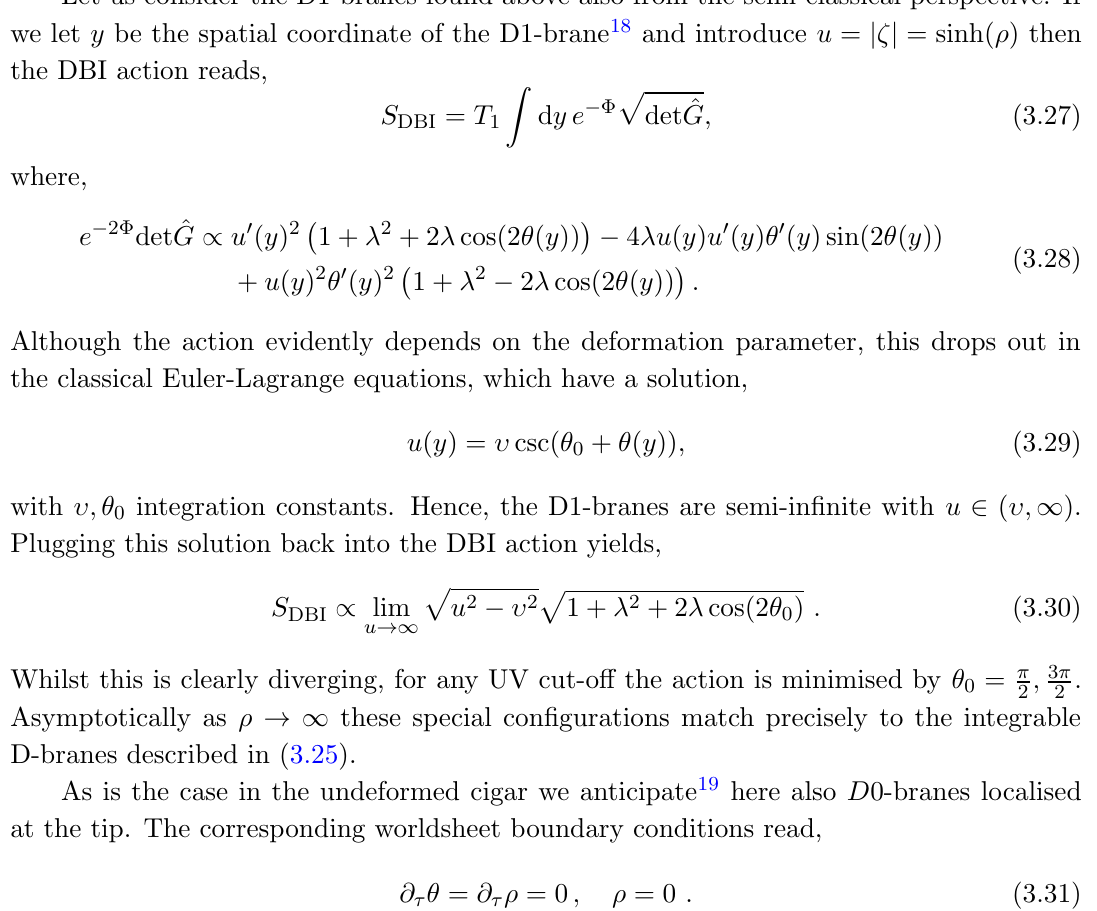
Figure 1 . The D1-brane con(cid:12)gurations in the undeformed cigar manifold embedded in R 3 . Heuris- tically, one can think of the deformation as to convert the U(1) (cid:18) circle into an ellipse. However, visualising this exactly is surprisingly challenging.